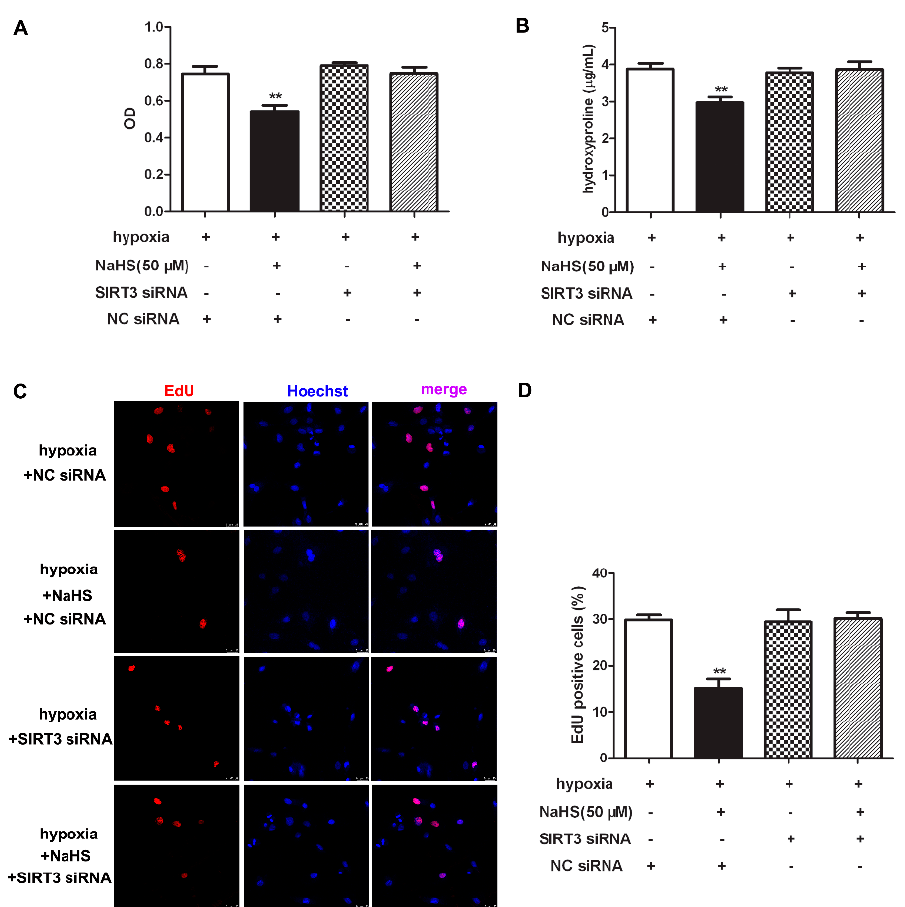
Figure 8. NaHS failed to inhibit cell proliferation after SIRT3 was knockdown in cardiac fibroblasts with hypoxia. After transfection by SIRT3 siRNA or NC siRNA for 48 h, neonatal rat cardiac fibroblasts were pre-administrated with NaHS (50 µ M) for 4 h followed by incubation with normoxia (containing 5% CO 2 and 95% O 2 ) or hypoxia (containing 5% CO 2 and 1% O 2 ) for another 4 h. ( A ) The cardiac fibroblast number was measured with a CCK-8 kit. ( B ) The hydroxyproline content in the cell culture medium was detected. ( C ) Cell proliferation was assessed by EdU (red) staining. The nuclei were stained with Hoechst (blue). Bar = 25 µ m. ( D ) The rate of EdU positive cells was quantified. ** p < 0.01 vs. hypoxia-induced cells with NC siRNA transfection, n = 6.